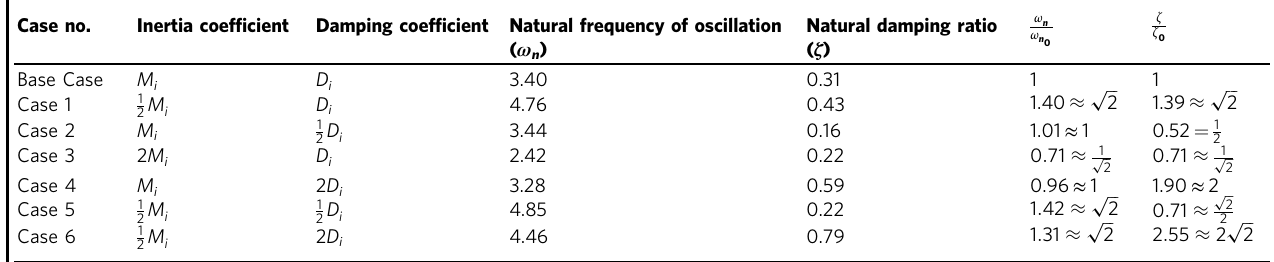
Here, ω 0 and ζ 0 are the natural frequency of oscillation and the natural damping ratio in the base case, respectively (see “ Methods ” for de fi nition). The coef fi cients for the base case is highlighted in the caption of Fig. 3. Values of ω n ω and ζ ζ quantify how the natural frequency of oscillation and the natural damping ratio in each subsequent case changes relative to those of the base case. The results here n 0 0 conclude that the natural frequency of oscillations is independent of the generator damping coef fi cient, D i , while the inverse square root of the inertia coef fi cient, M i , determines the frequency of oscillations. They also indicate the natural damping ratio is a function of the generator damping coef fi cient D i , with a direct relationship, and their inertia coef fi cient, M i , is a square root relationship. The results presented in this table are notable as they underline the signi fi cance of the damping component in achieving a stable synchronized frequency